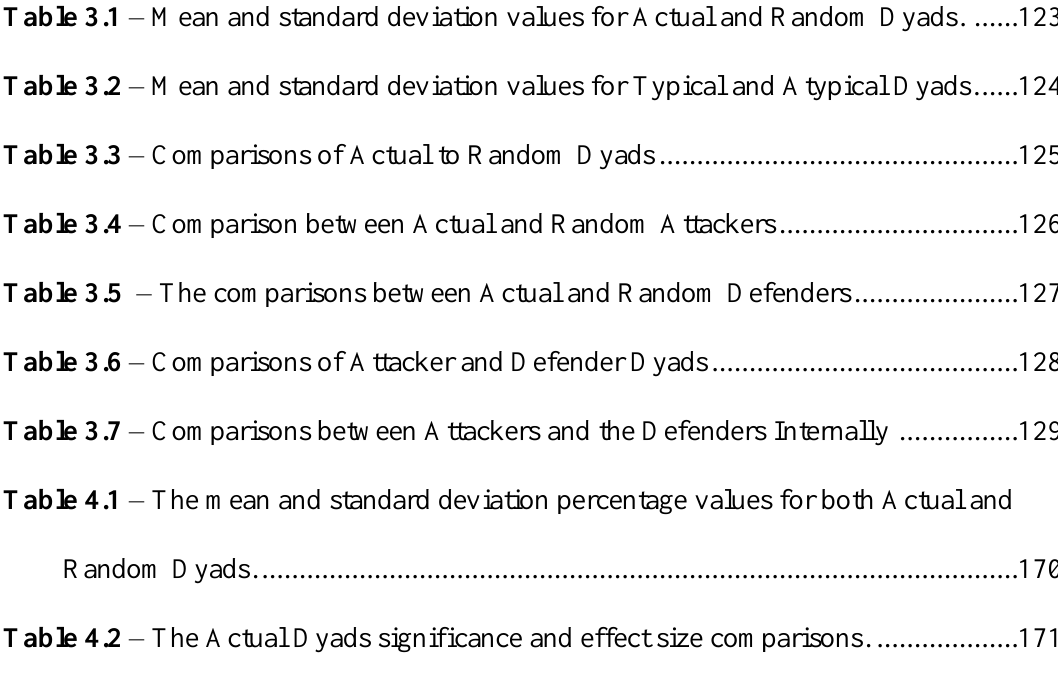
Table 4.2 – The Actual Dyads significance and effect size comparisons. ................... 171 Table 4.3 – Actual Dyad comparison between individual and combined experience.